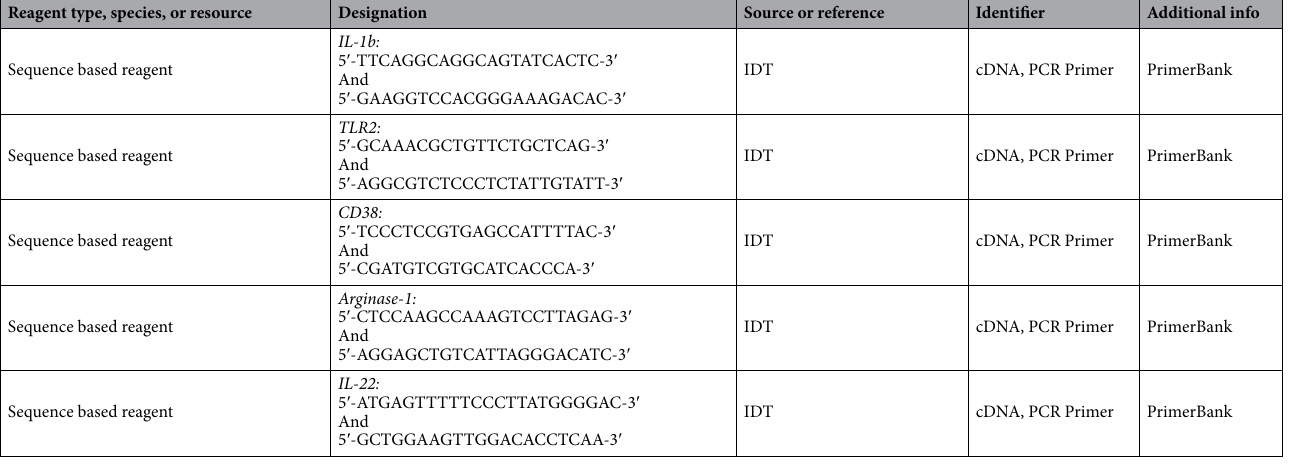
Table 1. Key Resources and